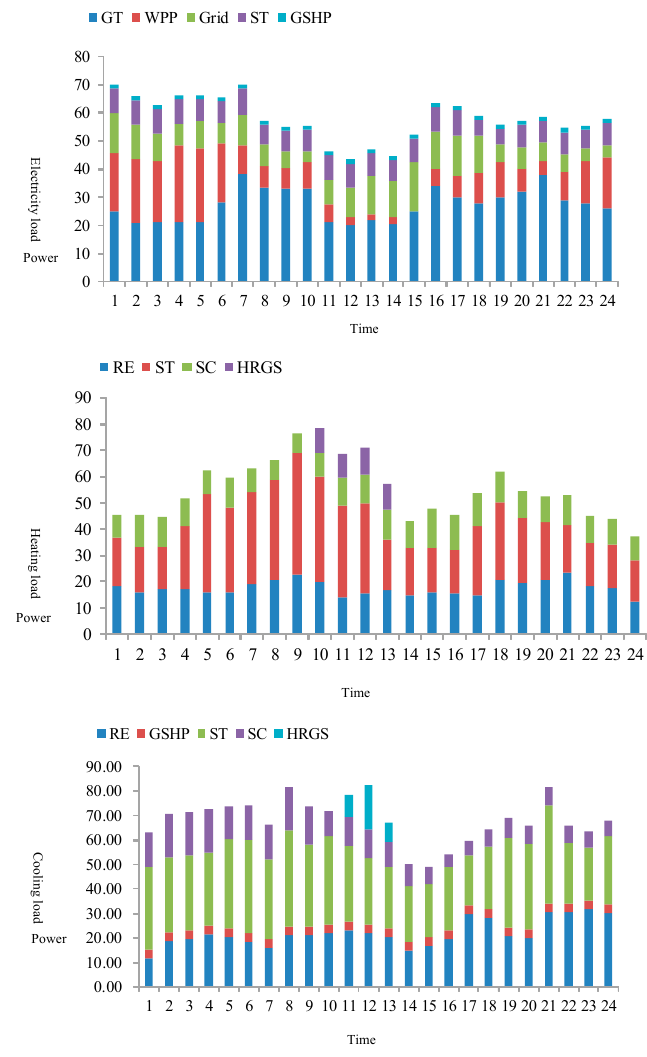
Figure 8. Hourly electric, heating, and cooling load supply of scenario 4 (unit: MW).